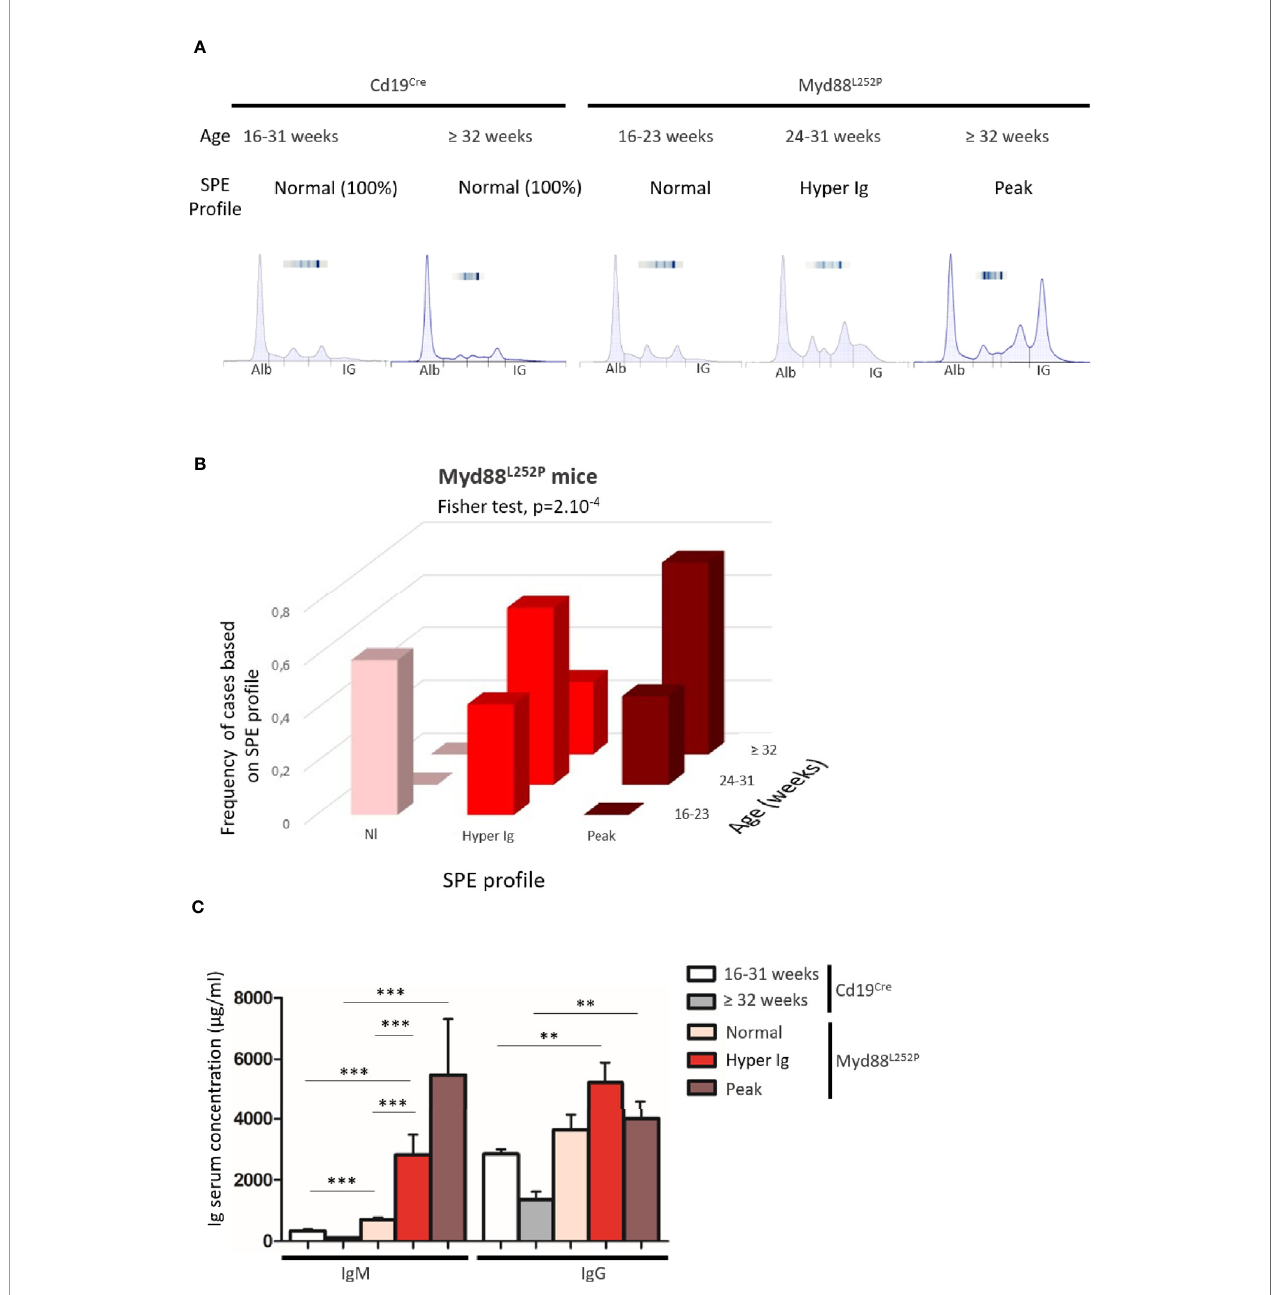
FIGURE 1 | Myd88 L252P transgenic mice exhibited serum IgM hypergammaglobulinemia and then monoclonal IgM peaks when ageing. (A) Examples of serum protein electrophoresis of Cd19 Cre mice (respectively 16 and 36 weeks-old) and three Myd88 L252P mice (16, 24 and 36 week-old) with normal, polyclonal hypergammaglobulinemia (hyper Ig) and monoclonal Ig peaks respectively. (B) Frequencies of cases according to SPE pro fi le and age for Myd88 L252P mice (n = 40). (C) IgM and IgG serum levels in Cd19 Cre and Myd88 L252P mice. For Cd19 Cre (n = 15), Myd88 L252P (n = 36). Results are expressed as the mean ± SEM. Mann Whitney test p-value < 0.01 and < 0.001 are symbolized by ** and ***